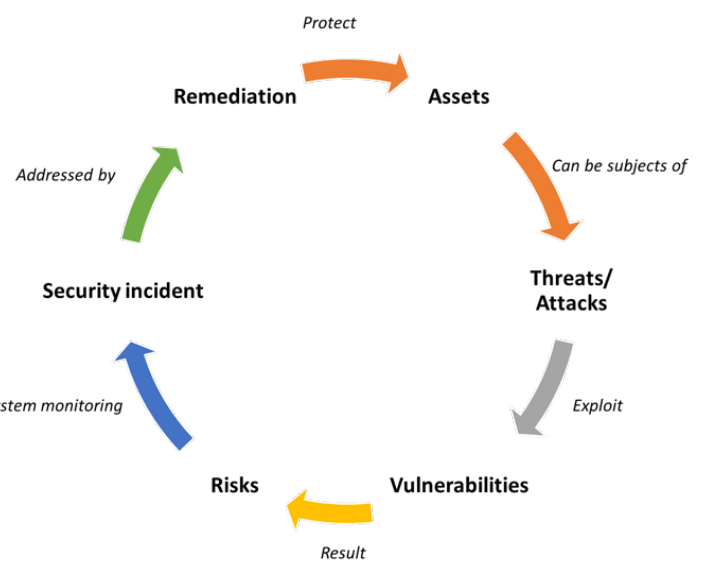
Figure 1. Risk-based monitoring